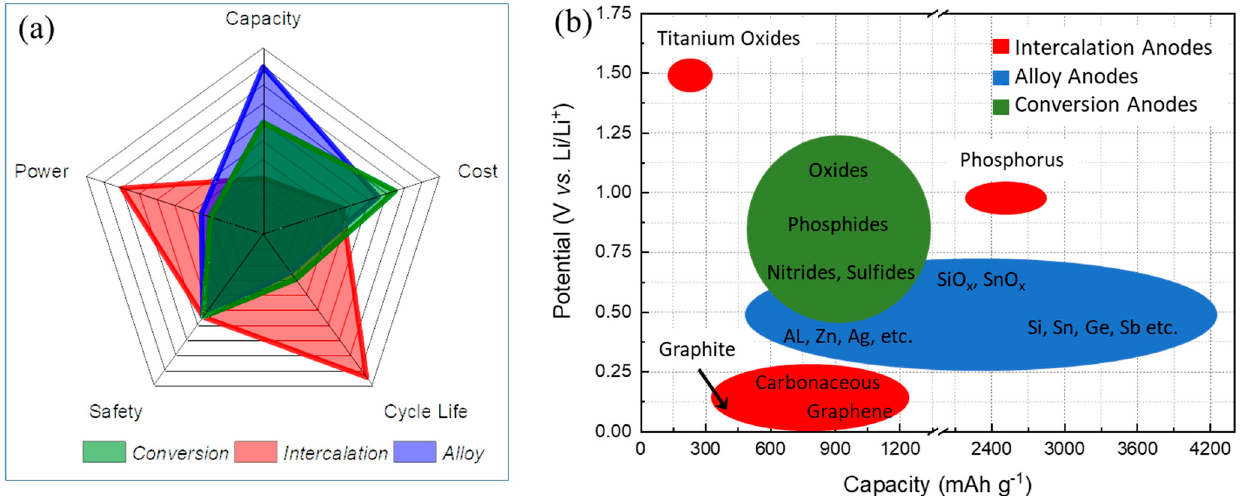
Figure 1. Anode active materials with three different primary electrochemical (de)lithiation mecha- nisms: ( a ) Radar plot comparing five critical categories of capacity, cost, cycle life, safety, and power. ( b ) Schematic illustration comparing potential vs. capacity of certain anode materials.